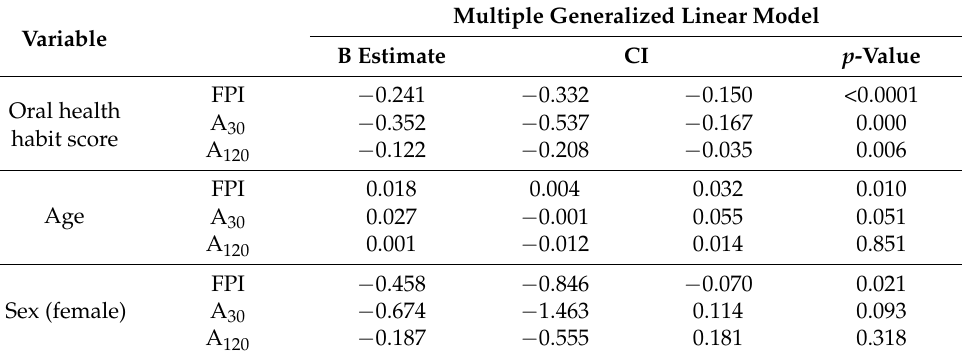
Table 3. The multiple generalized linear model estimate between the FPI adjusted by oral health habit score, age and sex.